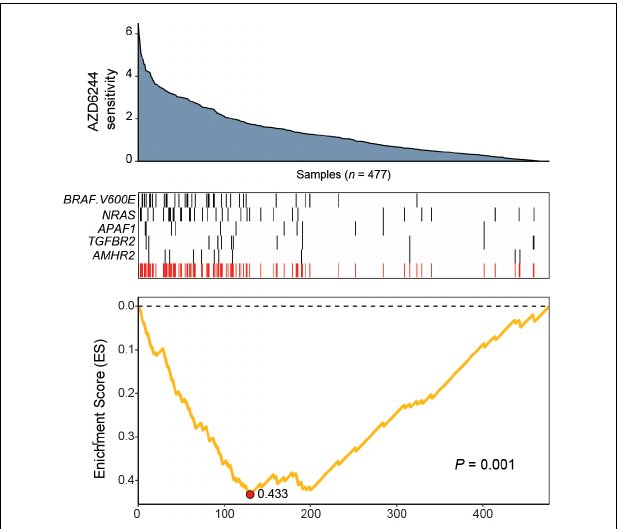
FIGURE 3 | CaDrA identifies mutations in MAPK/ErK signaling genes that contribute to hyper-sensitivity to MEK inhibition in vitro . ActArea measurements reflecting sensitivity to MEK inhibitor AZD6244 were used to rank CCLE cell lines ( n = 477). CaDrA was then run to identify sets of genomic features that were most-associated with decreasing ActArea (i.e., increasing sensitivity) scores. Through step-wise search iterations, CaDrA identified somatic mutations in known regulators upstream of MEK, including an activating mutation in BRAF (BRAF V 600 E ) and NRAS , as well as those in APAF1 , TGFBR2, and AMHR2 , before terminating the search process. The resulting meta-feature (red track) and its corresponding enrichment score (ES) is